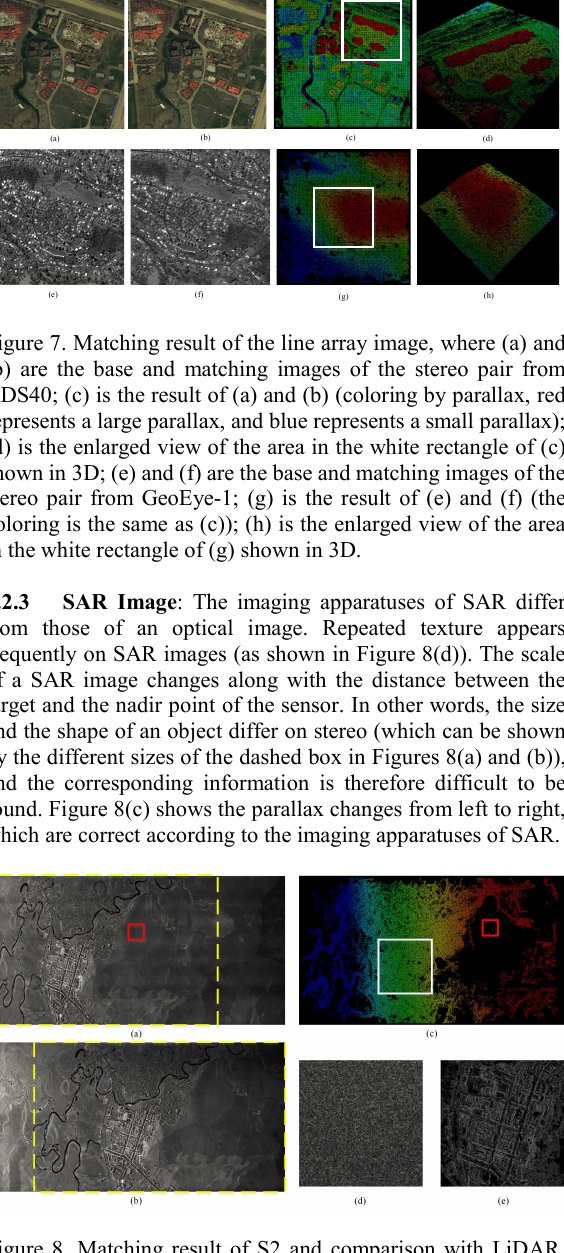
Figure 8. Matching result of S2 and comparison with LiDAR, where (a) and (b) are the base and matching images of the stereo pair, respectively, and the areas within the dashed boxes represent the overlapping of the image pair; (c) the result of